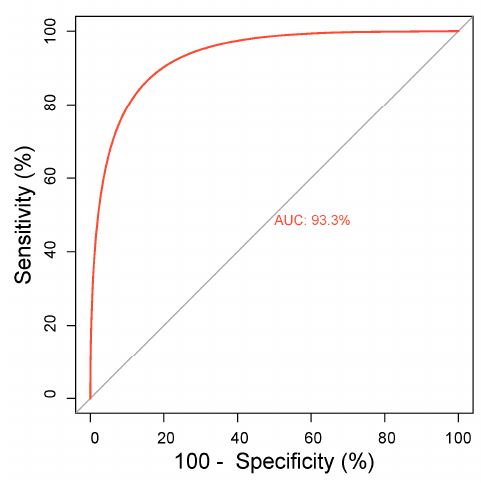
Figure 24. ROC Curve of ResNet Model.